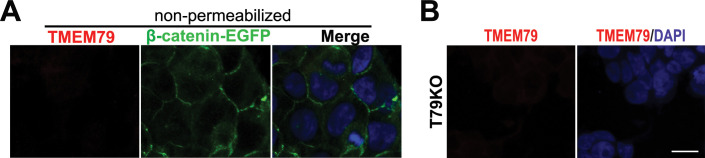
TMEM79 is an ER-resident protein.(A) TMEM79 is not detectable by the TMEM79 antibody without cell permeabilization. Note that the antibody (Key Resources Table) recognizes the TMEM79 C-terminus (Figure 1D), which is either in the ER lumen, or extracellular if TMEM79 were to be on the PM. This result is consistent with TMEM79 being an ER- but not PM-resident protein. (B) T79KO cells lack TMEM79 staining completely, demonstrating specificity of the TMEM79 antibody for immunostaining. Scale bar = 10 μm.